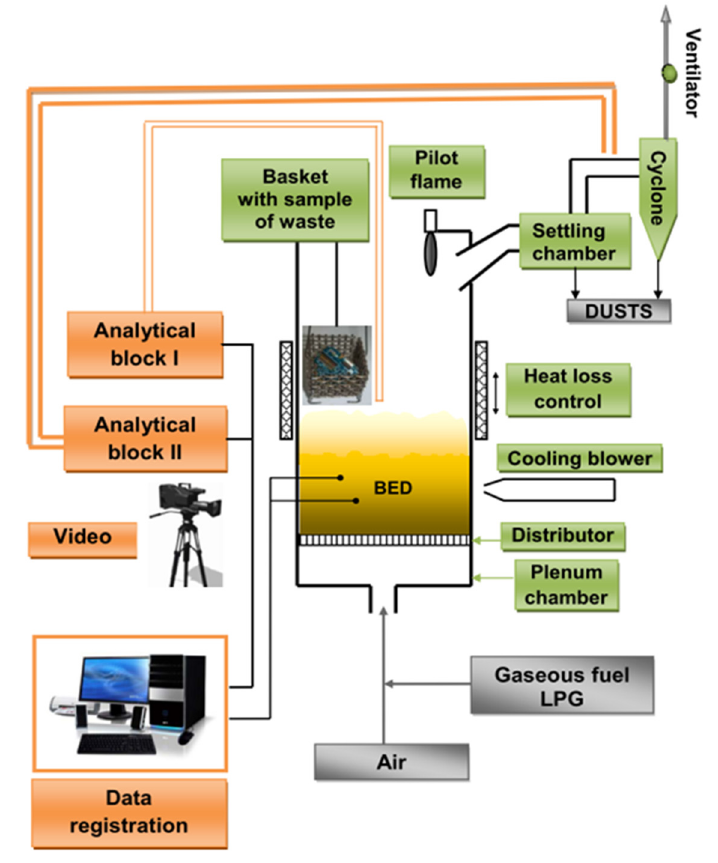
Figure 1. Diagram of a laboratory fluidised bed reactor.